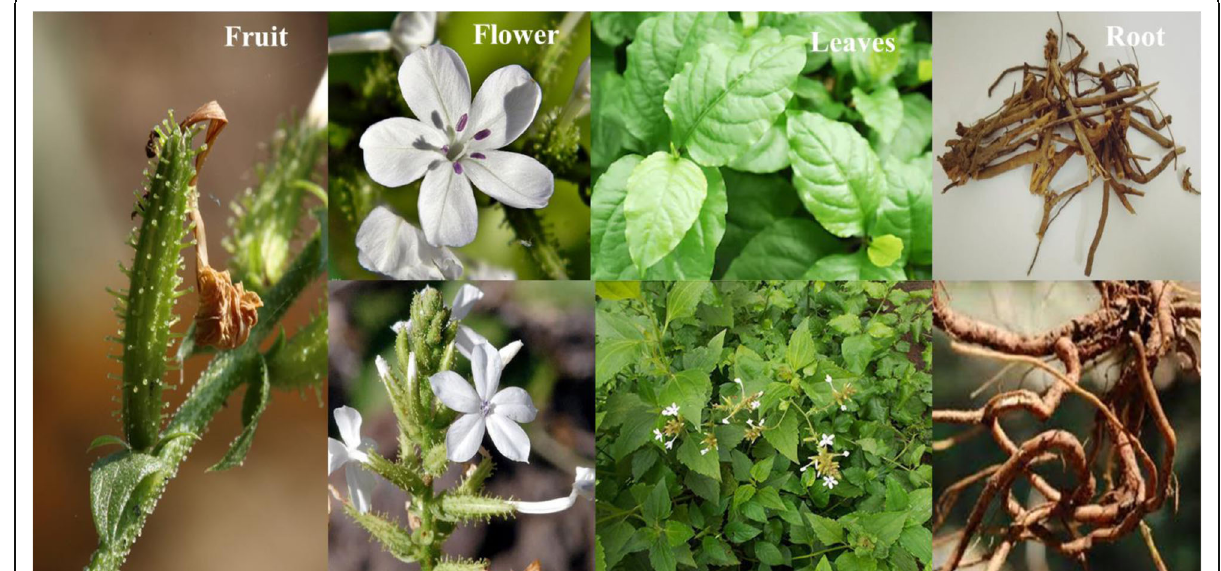
Fig. 2 Morphological description of the Plumbago zeylanica L. [7]